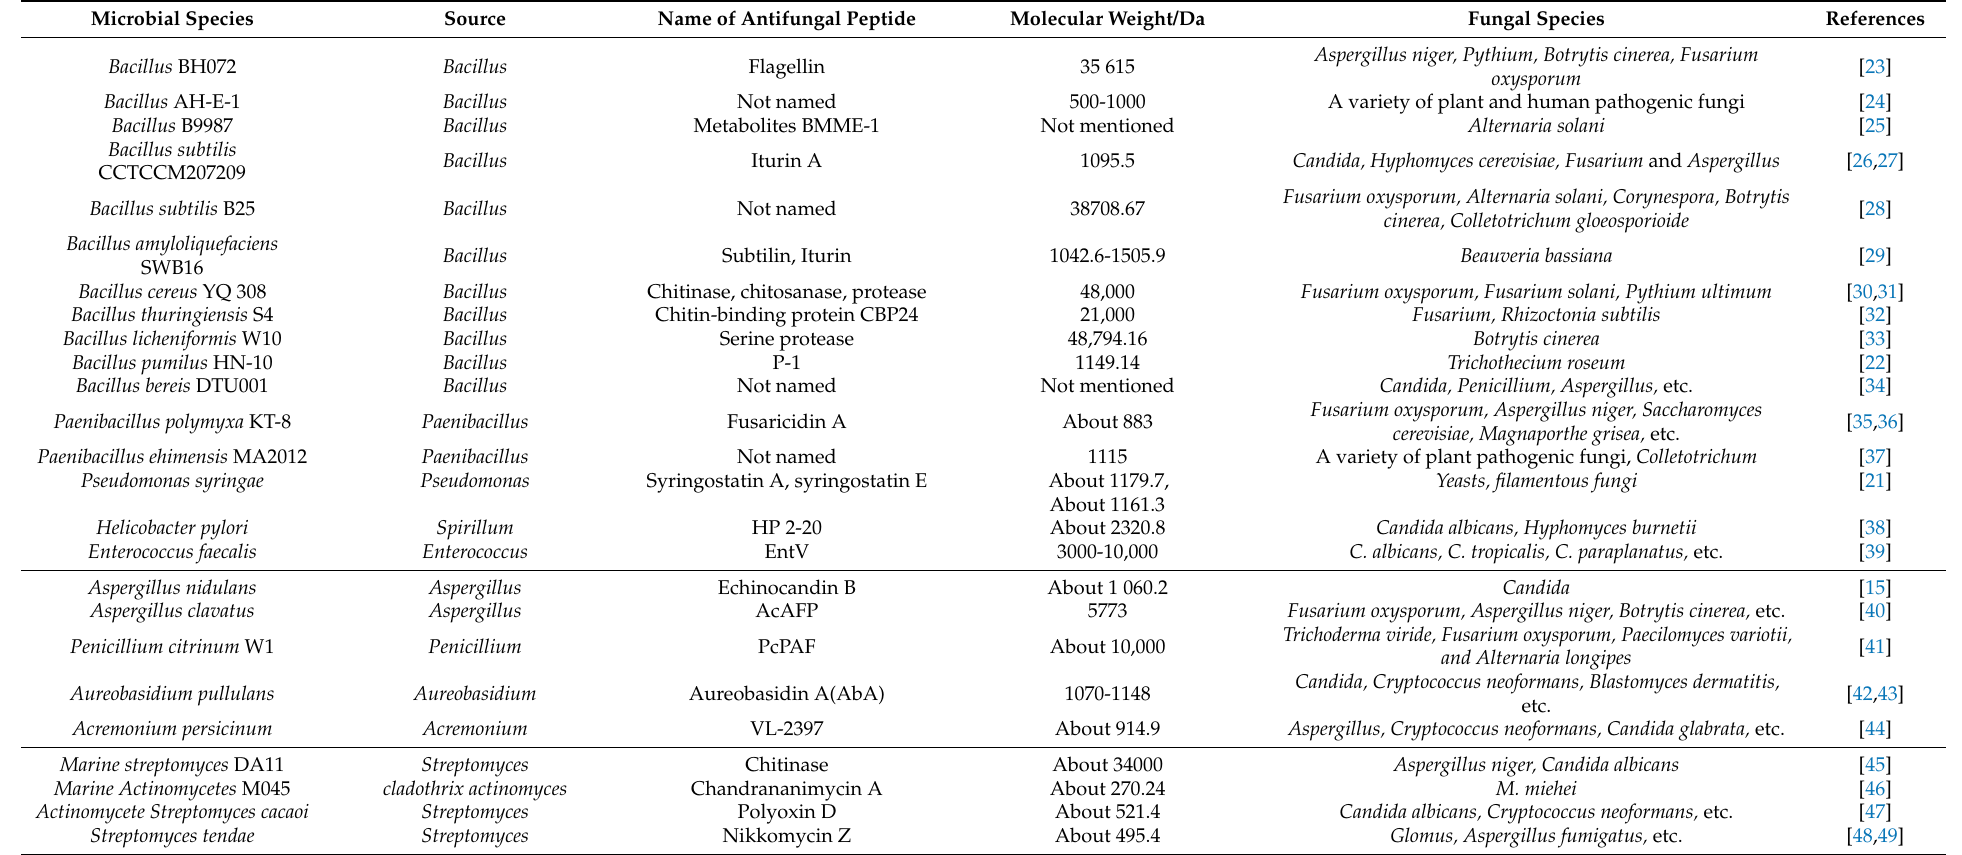
Table 1. Antifungal microorganisms derived from different species and genera and the species of fungi they act